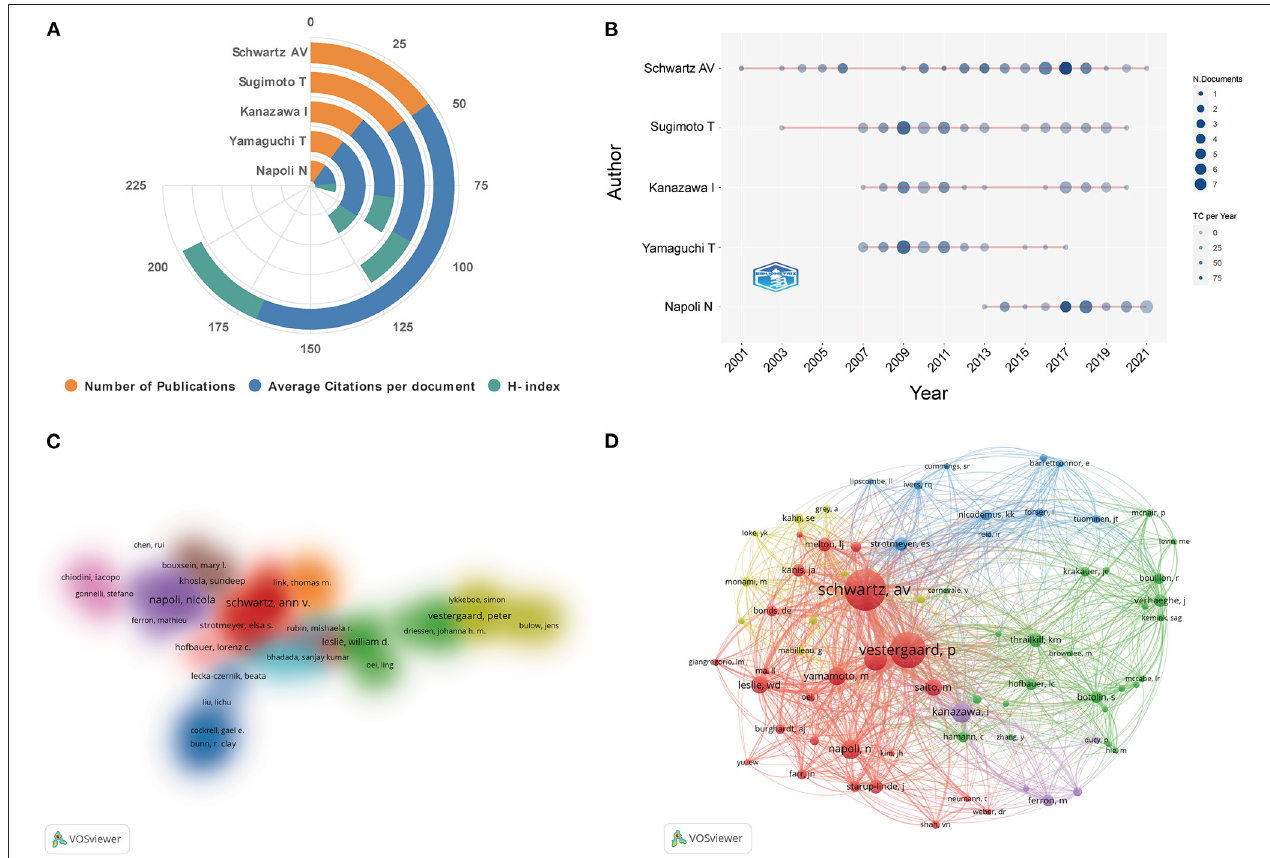
FIGURE 5 | (A) Total number of publications, average citations per document, and H-index of top 5 authors in this area. (B) Top 5 authors’ production over time. The circle size represents the number of documents (N. Documents), and the shade of the color signifies the total number of citations (TC). (C) The cluster density map of author co-authorship analysis generated by VOSviewer. Authors with close cooperation relationship are assigned to one cluster with the same color. (D) The network visualization map of author co-citation analysis generated by VOSviewer. Each author is represented as a node, and the node size is proportional to the sum of citations. A link between two nodes indicates a co-citation relationship. The distance between nodes indicates the relatedness, and a smaller distance implies a higher relatedness and will be assigned to one cluster with the same